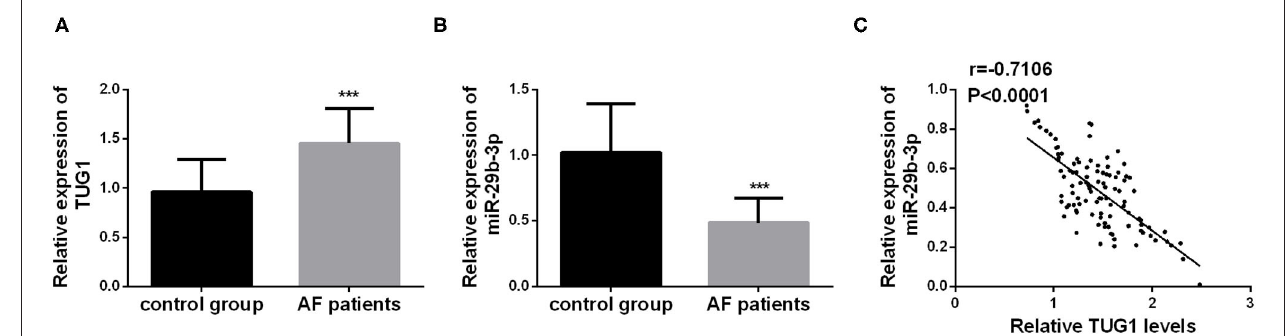
FIGURE 1 | Aberrant expression of TUG1 and miR-29b-3p in AF patients. (A) TUG1 was highly expressed in the serum of AF patients compared with the healthy controls (*** p < 0.001). (B) miR-29b-3p was downregulated in AF patients compared with the control group (*** p < 0.001). (C) Serum TUG1 showed negative correlation with the level of miR-29b-3p in AF patients ( r = − 7.106, p < 0.001).